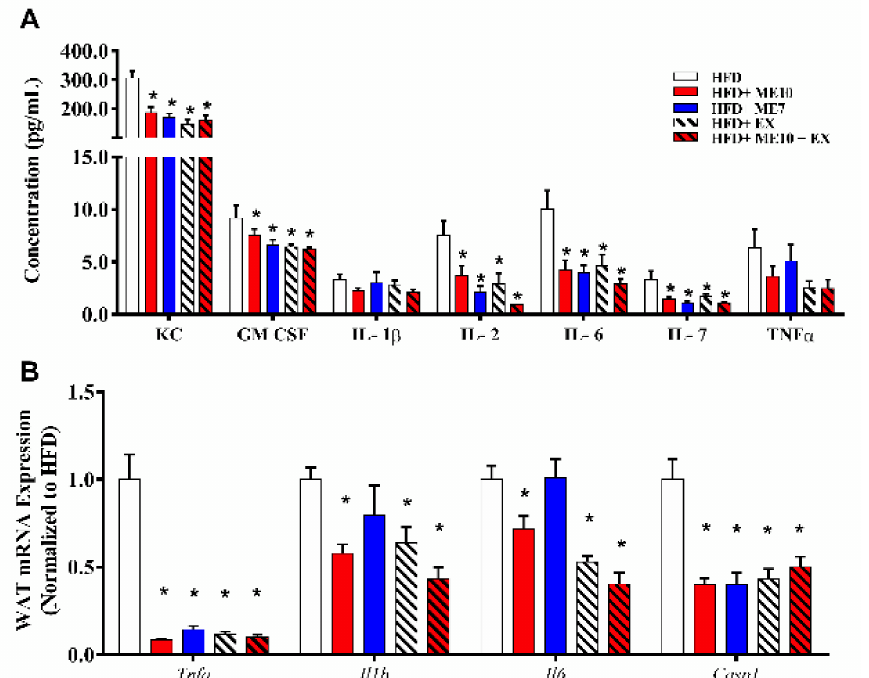
Figure 3. Metabolic enhancer (ME) supplementation and/or exercise reduces circulating inflamma- tory cytokines ( A ), and simultaneously reduces mRNA expression ( B ) in white adipose tissue (WAT). 1-way ANOVA with Fisher’s LSD post-hoc test. *: p < 0.05 compared to the high-fat diet (HFD) group. Data are represented as the mean ± SEM ( n = 8–12 per